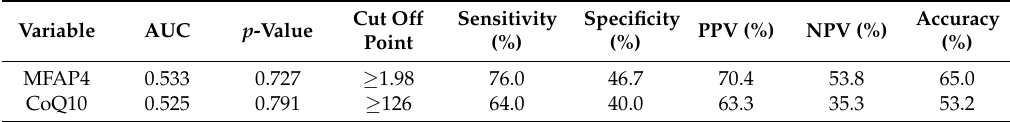
Table 4. Diagnostic performance of MFAP4 and oxidized CoQ10 for the prediction of dead hepatocellular carcinoma patients.